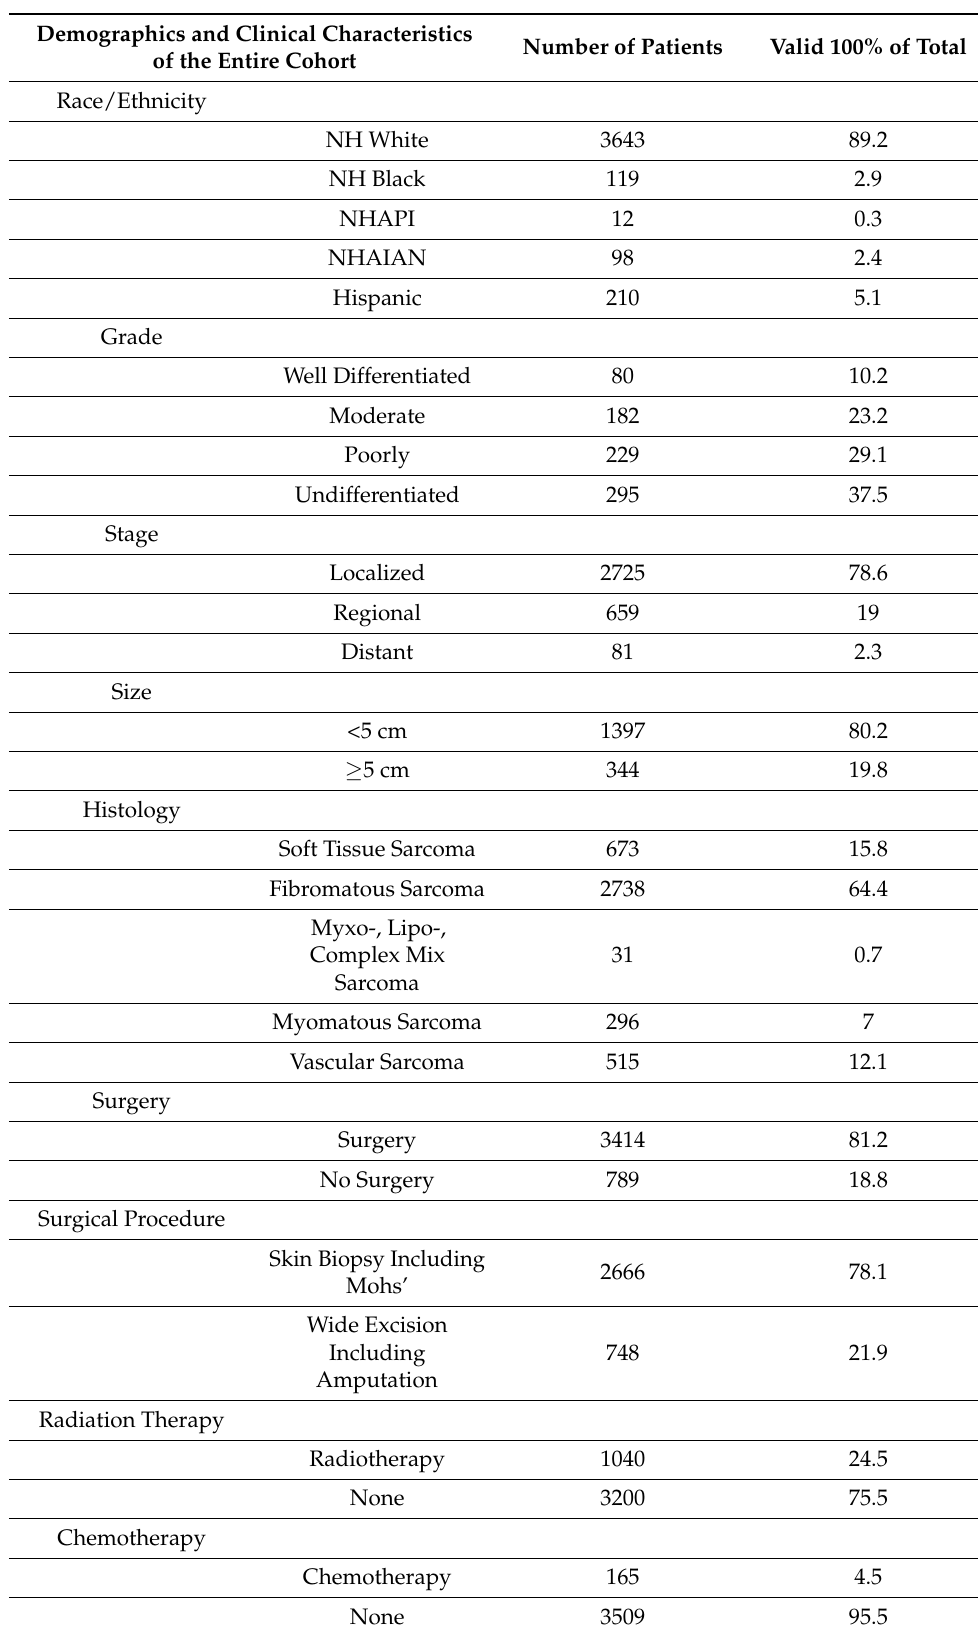
Table 1. Cont. Demographics and Clinical